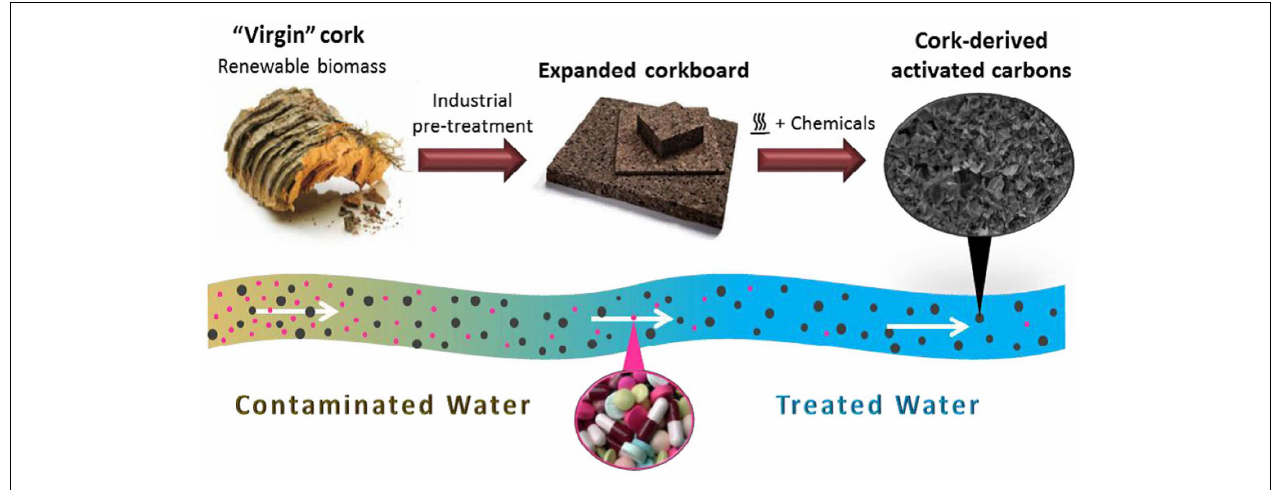
FIGURE 6 | Scheme of preparation of cork-based adsorbents for pharmaceutical compounds removal (Mestre et al., 2014)